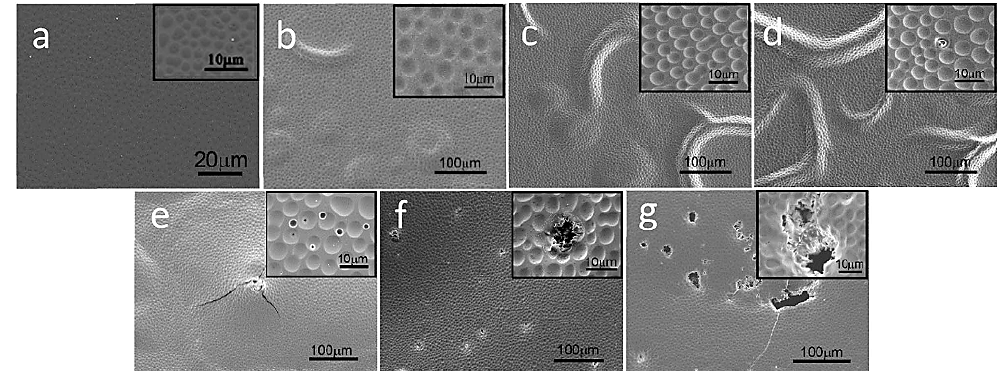
Figure 5. SEM micrographs of the coating surface during immersion test, ( a ) 0 d, ( b ) 1 d, ( c ) 4 d, ( d ) 7 d, ( e ) 21 d, ( f ) 37 d, and ( g ) 58 d of HF-pretreated Mg–Nd–Zn–Zr (F-JDBM) samples. Reprinted with permission from [45]; Copyright 2017 Elsevier.